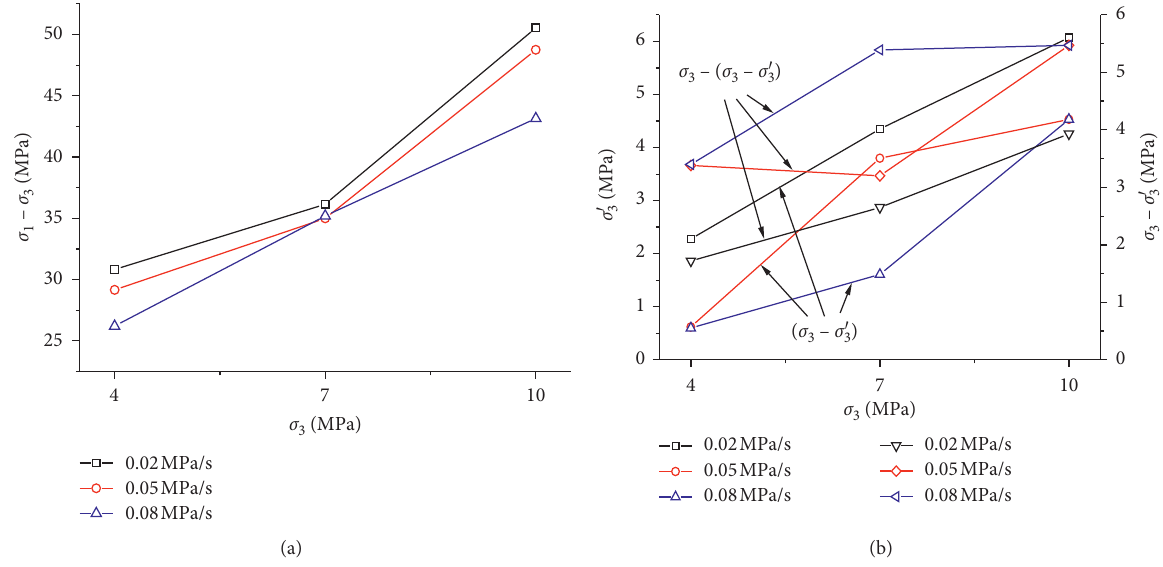
Figure 9: Comparison of samples under different confining pressure unloading rates. (a) Major stress difference. (b) Confining pressure and confining pressure difference during failure. Table 3: Values of c and φ of coal samples under different test